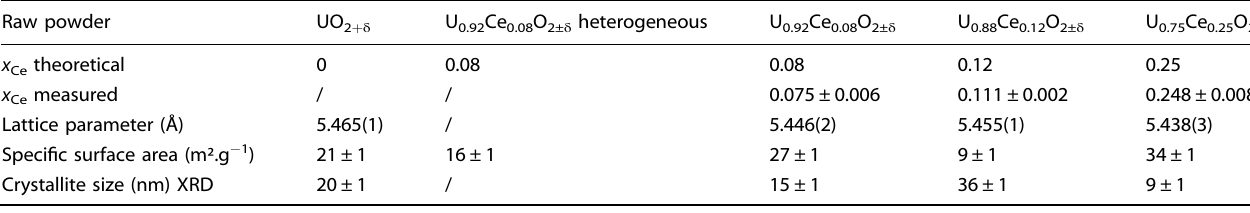
Table 1. Powdered materials properties.